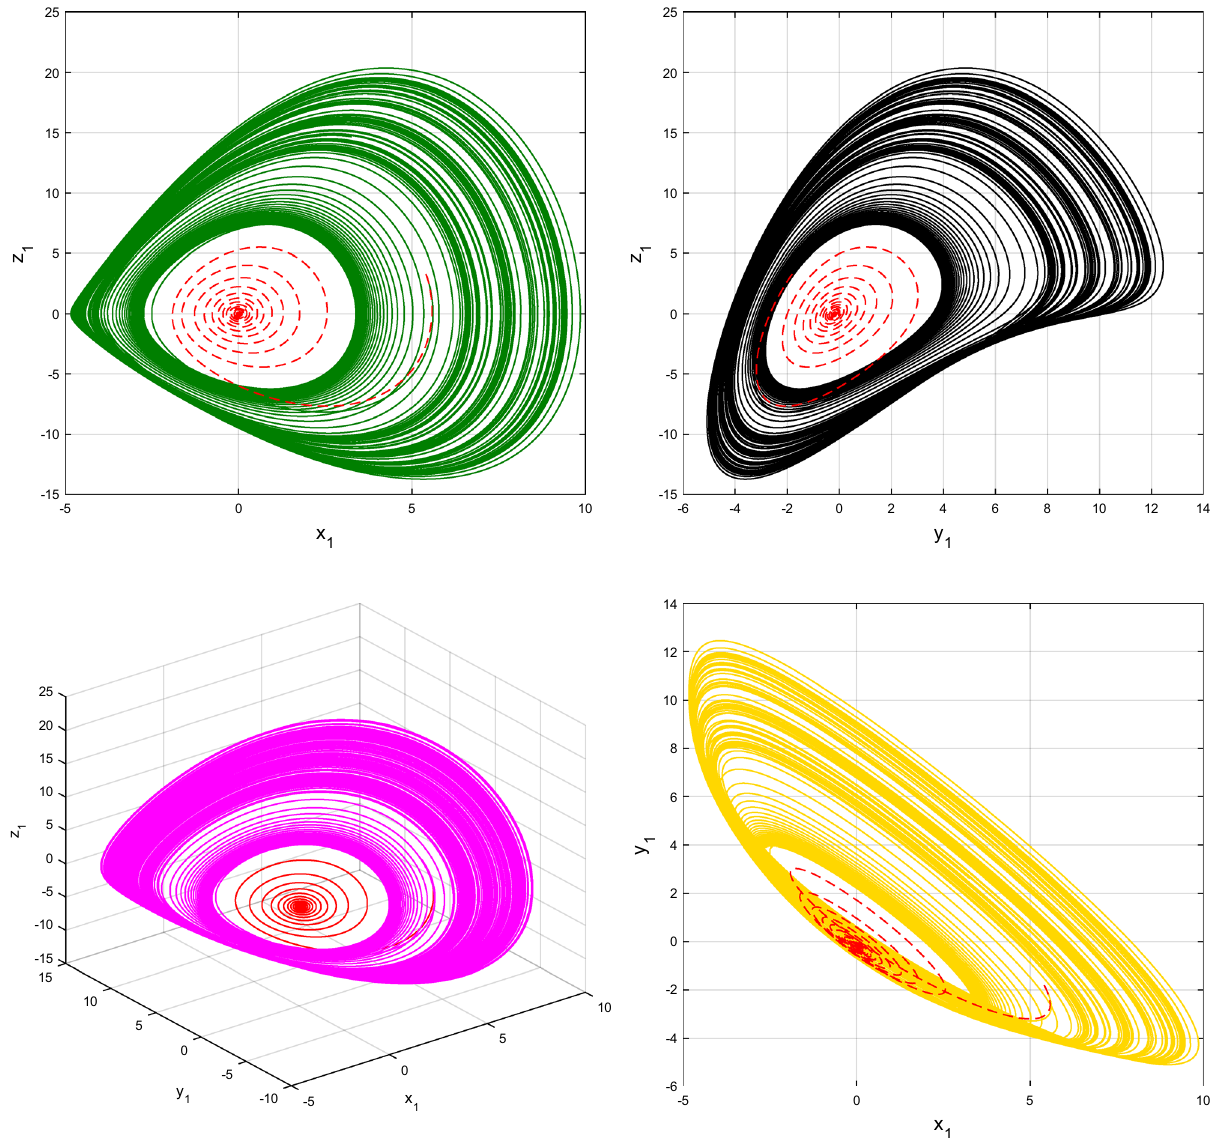
Figure 4. The case’s chaotic attractor dynamics, shown in 2D and 3D phase portraits when α = 1 (line) and α = 0.95